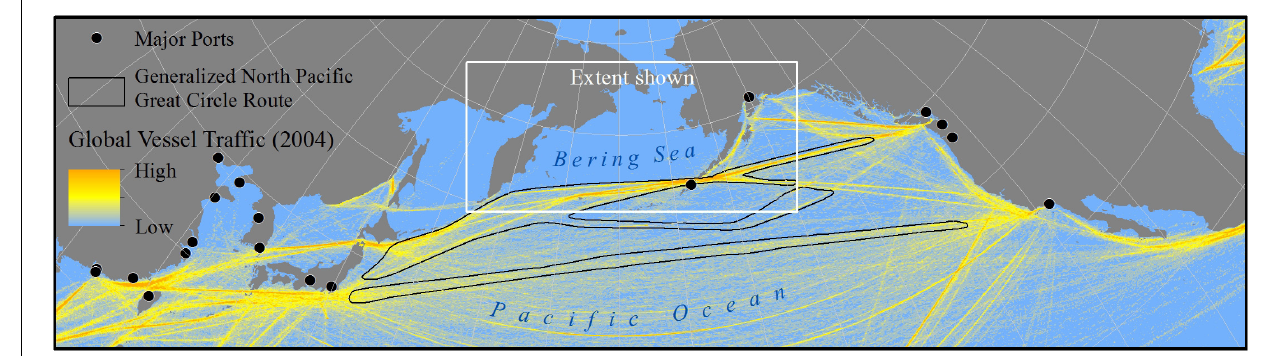
FIGURE 1 | Global vessel commerce in the North Pacific Ocean. Major ports are shown as black points and 1 year of global vessel traffic is shown as a color gradient to represent commonly used routes. Areas of concentrated vessel traffic along the North Pacific Great Circle Route are outlined by generalized black polygons. Global vessel traffic data is for 2004 and is provided by Halpern et al.